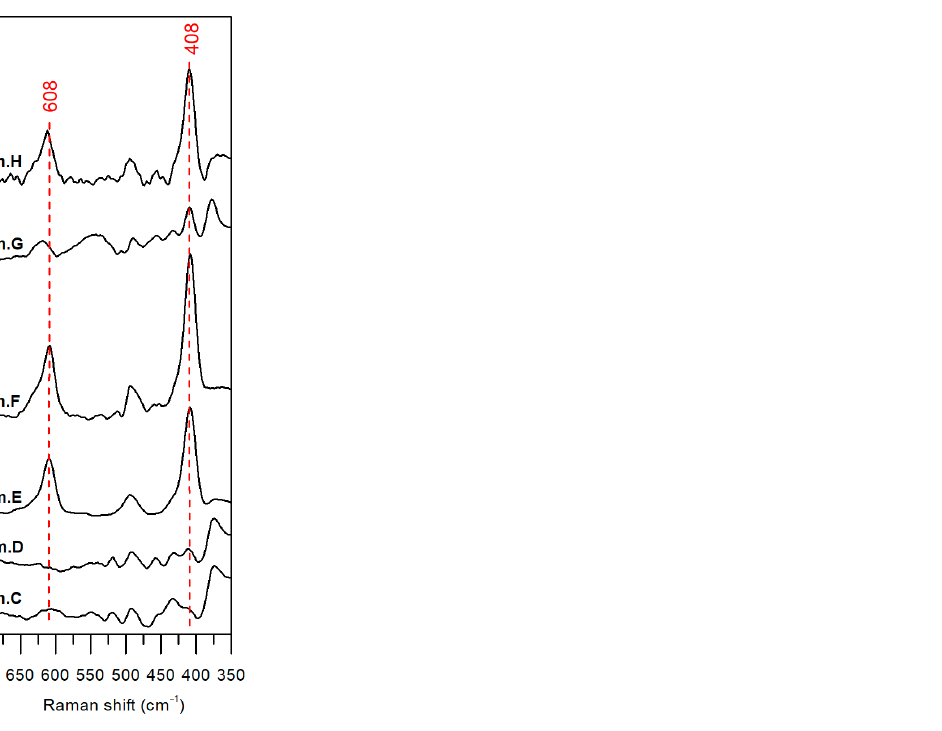
Figure 8. Representative Raman spectra collected on the mock-ups in correspondence of the areas characterized by talc concentration in the ground of 1%. Marker bands of hematite (red dotted line) are highlighted.